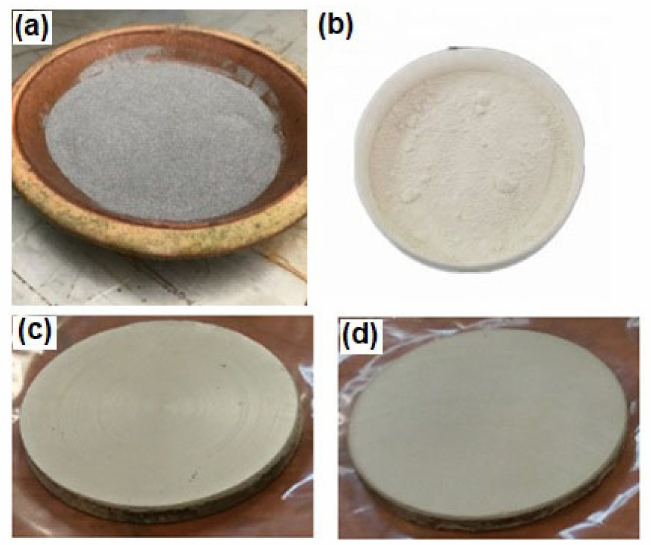
Figure 1. ( a ) Magnesium powder, ( b ) SiO 2 nanopowder, ( c , d ) composite samples after